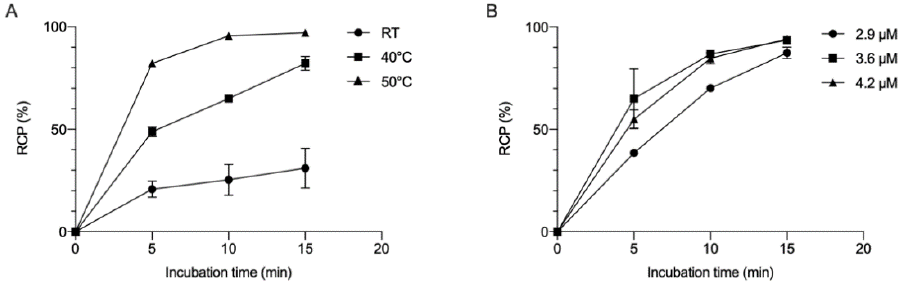
Figure 2. Optimization of the 68 Ga-labeling of NOTA-mal-(hPD-L1) Nb: ( A ) Radiochemical purity (RCP) in %, expressed in function of the incubation time (min) at three different temperatures (room temperature (RT), 40 °C and 50 °C) at a constant Nb concentration of 3.6 μM. ( B ) Radiochemical purity (RCP) in %, expressed in function of the incubation time (min) at three different Nb concentrations (2.9 μM, 3.6 μM and 4.2 μM) at 50 °C.